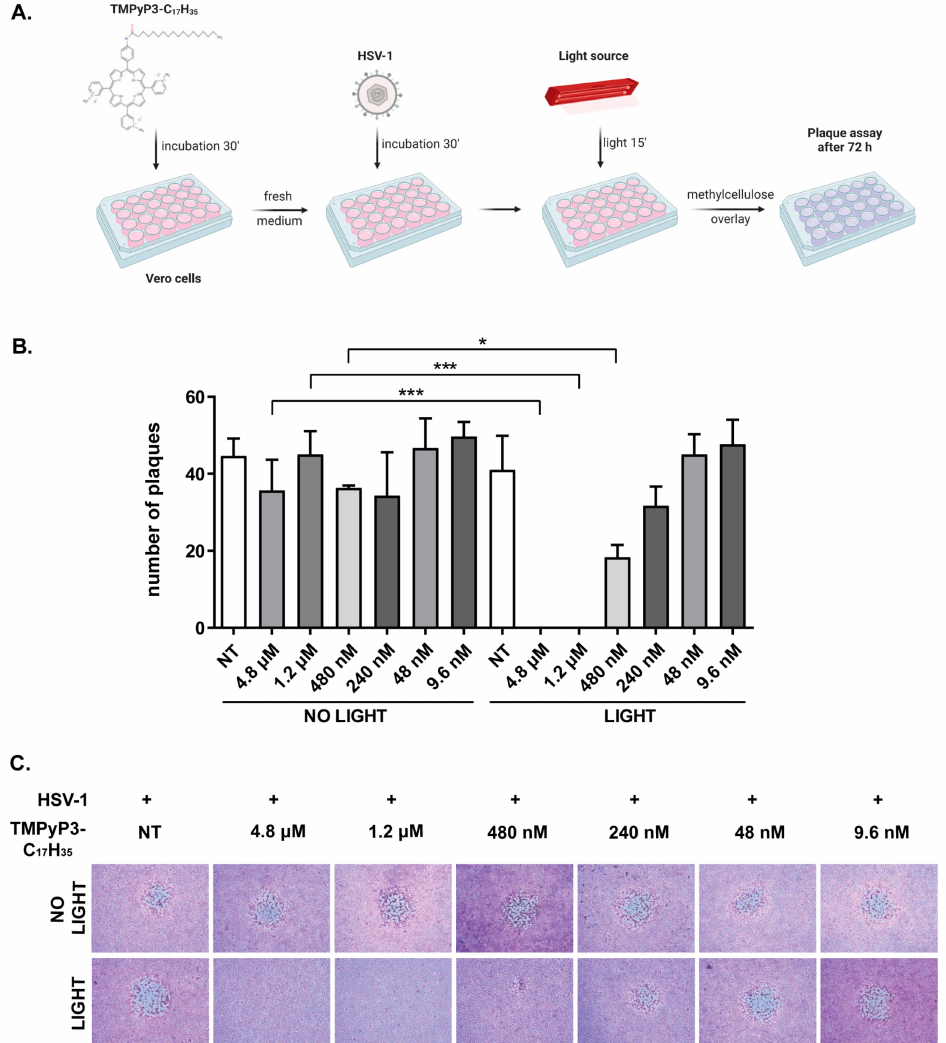
Figure 4. TMPyP3-C 17 H 35 inhibits replication of HSV-1. Vero cells were treated with a wide range of concentrations of TMPyP3-C 17 H 35 (9.6 nM–4.8 µ M), infected with HSV-1 at a very low MOI and irradiated. One hour after infection, cells were overlaid with methylcellulose and left for an additional 72 h to develop plaques; cells were then fixed and stained, and the number of plaques was determined. ( A ) Schematic representation of the experiment. ( B ) The number of plaques developed after treatment with different TMPyP3-C 17 H 35 concentrations. ( C ) Images of the fixed plaques were obtained using inverted microscope at 50 × magnification. All samples were tested in triplicate and data were analyzed using ANOVA, post-hoc Turkey’s multiple comparison test ( p values indicate significant differences; *** p = 0.0001, * p <